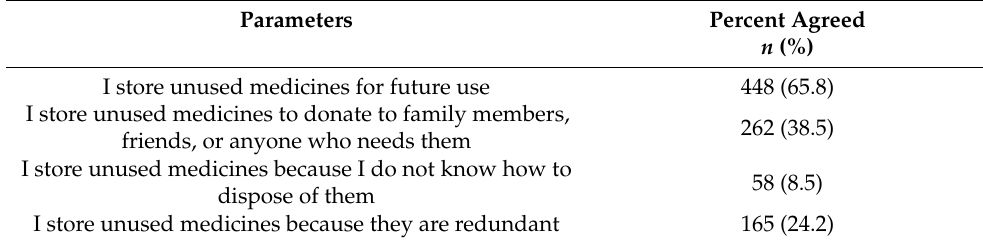
Table 3. Reasons for storing unused medicines as reported by the study participants ( n = 681).